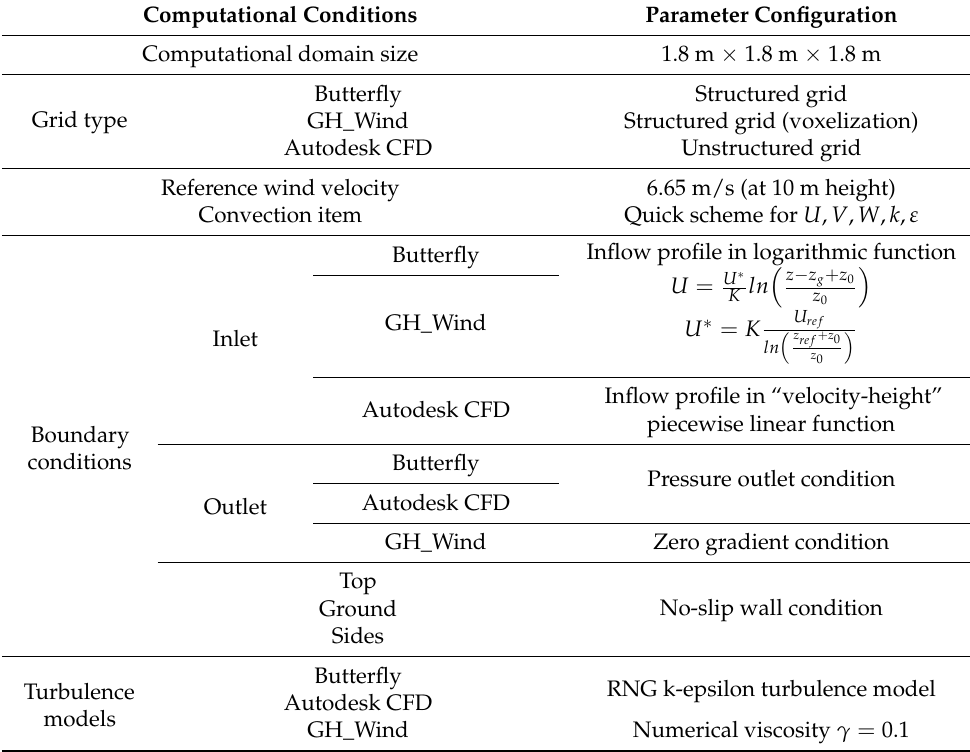
Table 4. The setup of CFD plug-in simulations for urban wind environment